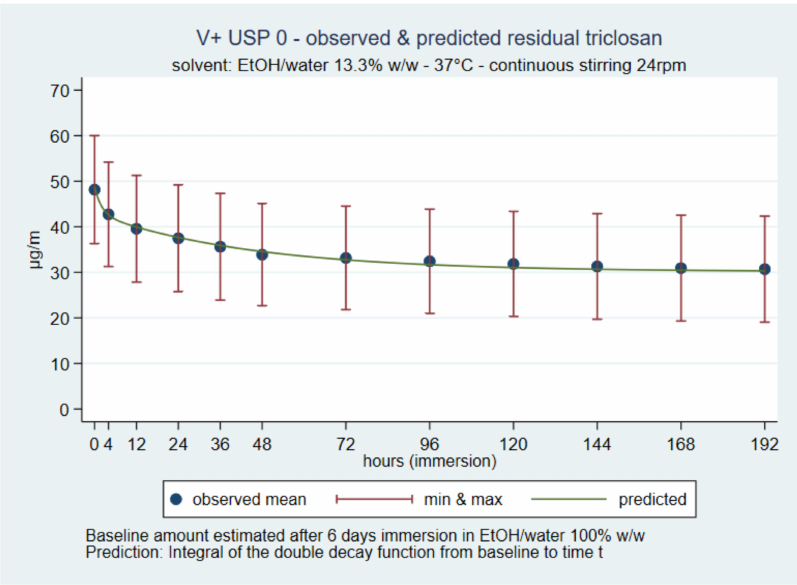
Figure 6. V+ 0 in 13.3% w / w predicted residual triclosan over